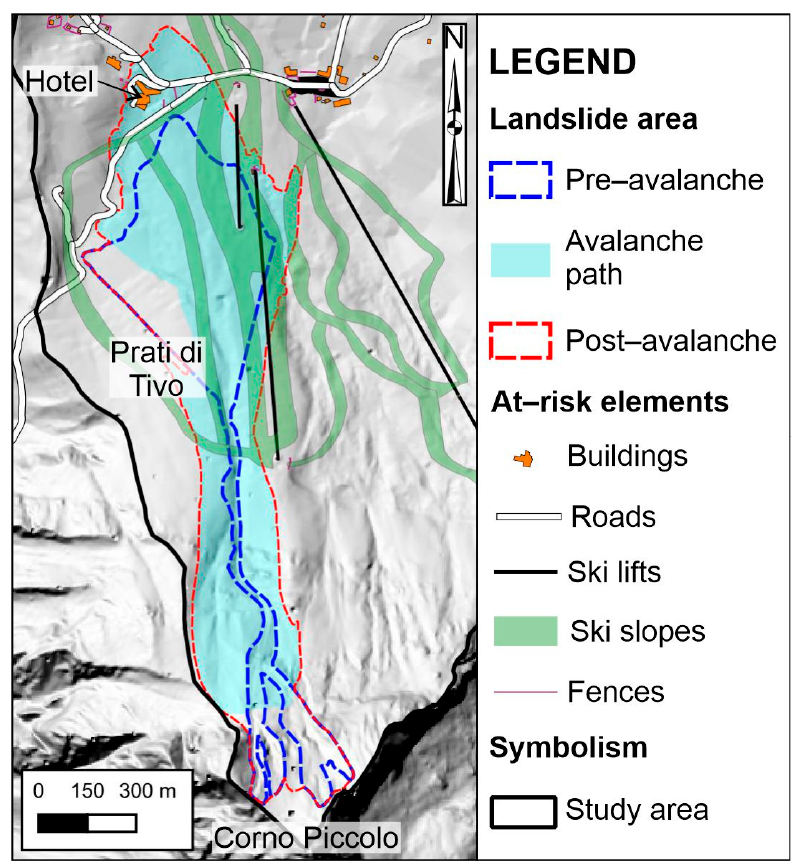
Figure 18. Pre- and post-avalanche landslide contributing area. Table 4. Dimensions of the possible landslide area, modified by snow avalanche dynamics.